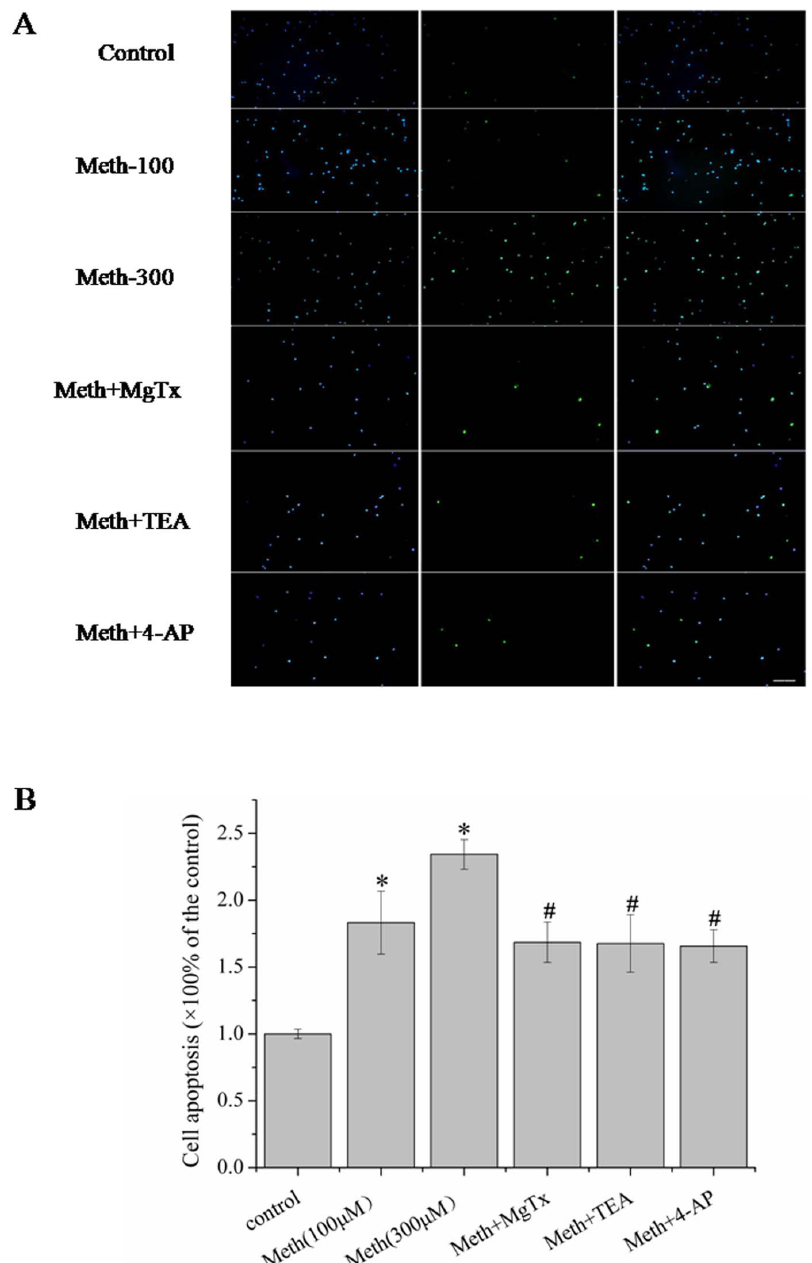
Figure 3. Kv1.3 was involved in Meth-induced microglial cell apoptosis, and the cell apoptosis was evaluated by performing the TUNEL assay. (A) Microglial cells were incubated with Meth (100,300 m M) for 24 h, and the apoptotic cells were markedly increased. (B) The cells were pre-incubated with 4-AP (1 mM), TEA (5 mM) and MgTx (10 nM) for 30 min before addition of Meth (300 m M). Apoptotic cells were substantially attenuated by the MgTx, or the broad spectrum Kv channel blockers 4-AP and TEA. The results are representative of three independent experiments performed in triplicate determinations. * indicates significant difference when the values were compared to that of the control. (*p , 0.05) and # indicates significant difference when the values were compared to that of the Meth treated group (300 m M). Scale bars indicate 100 m